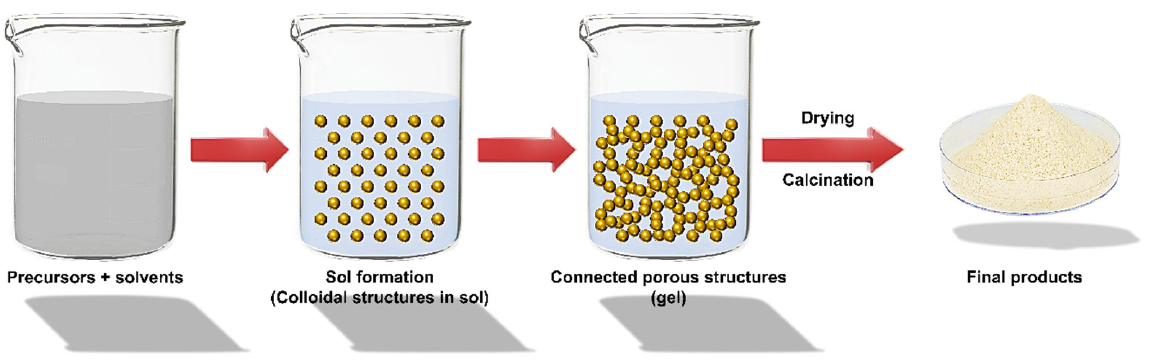
Figure 1. Scheme of Sol – gel synthesis.